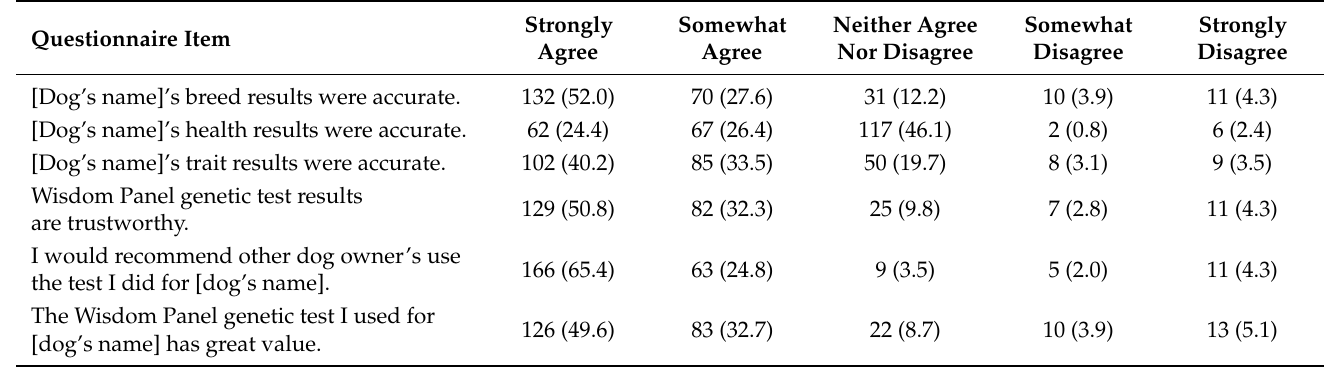
Table 5. Participant responses to Likert items about their perceptions, attitudes, and beliefs about the genetic test results received. Reported as N (Percent).